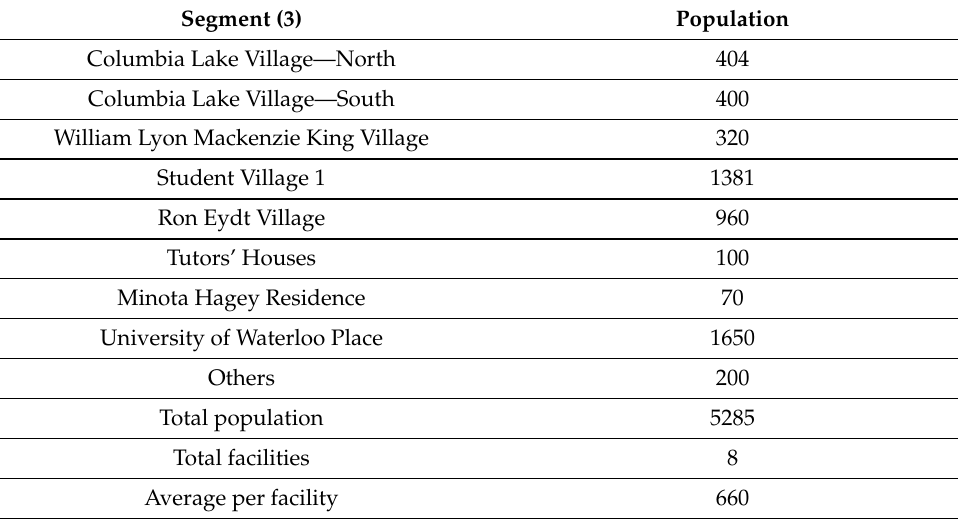
Table 5. Descriptive Statistics for Student Residence Buildings.